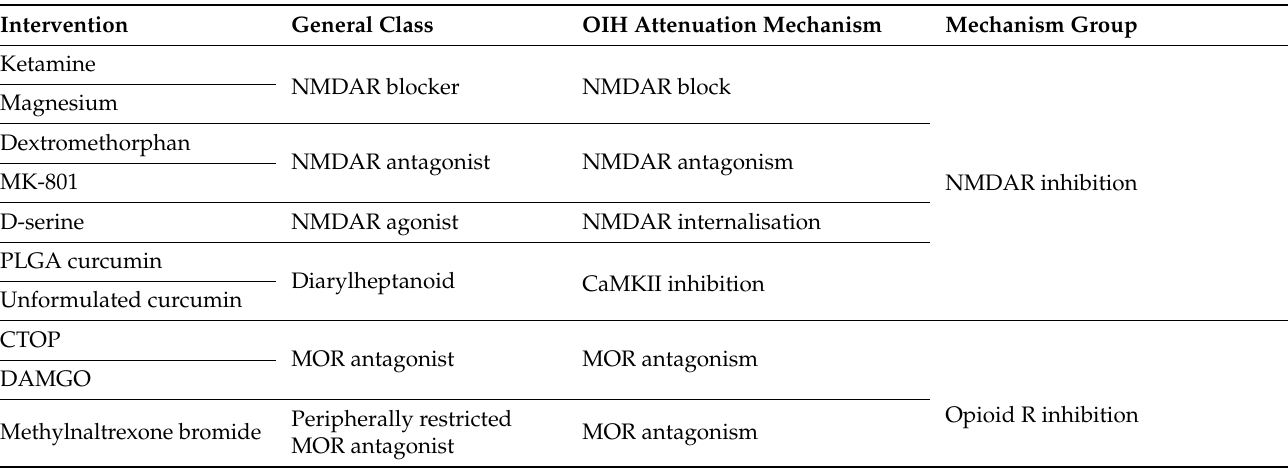
Table 8. Mechanisms of the interventions in morphine trials. General class of 52 interventions, OIH attenuation mechanism, and mechanism group based on the shared pathway for OIH